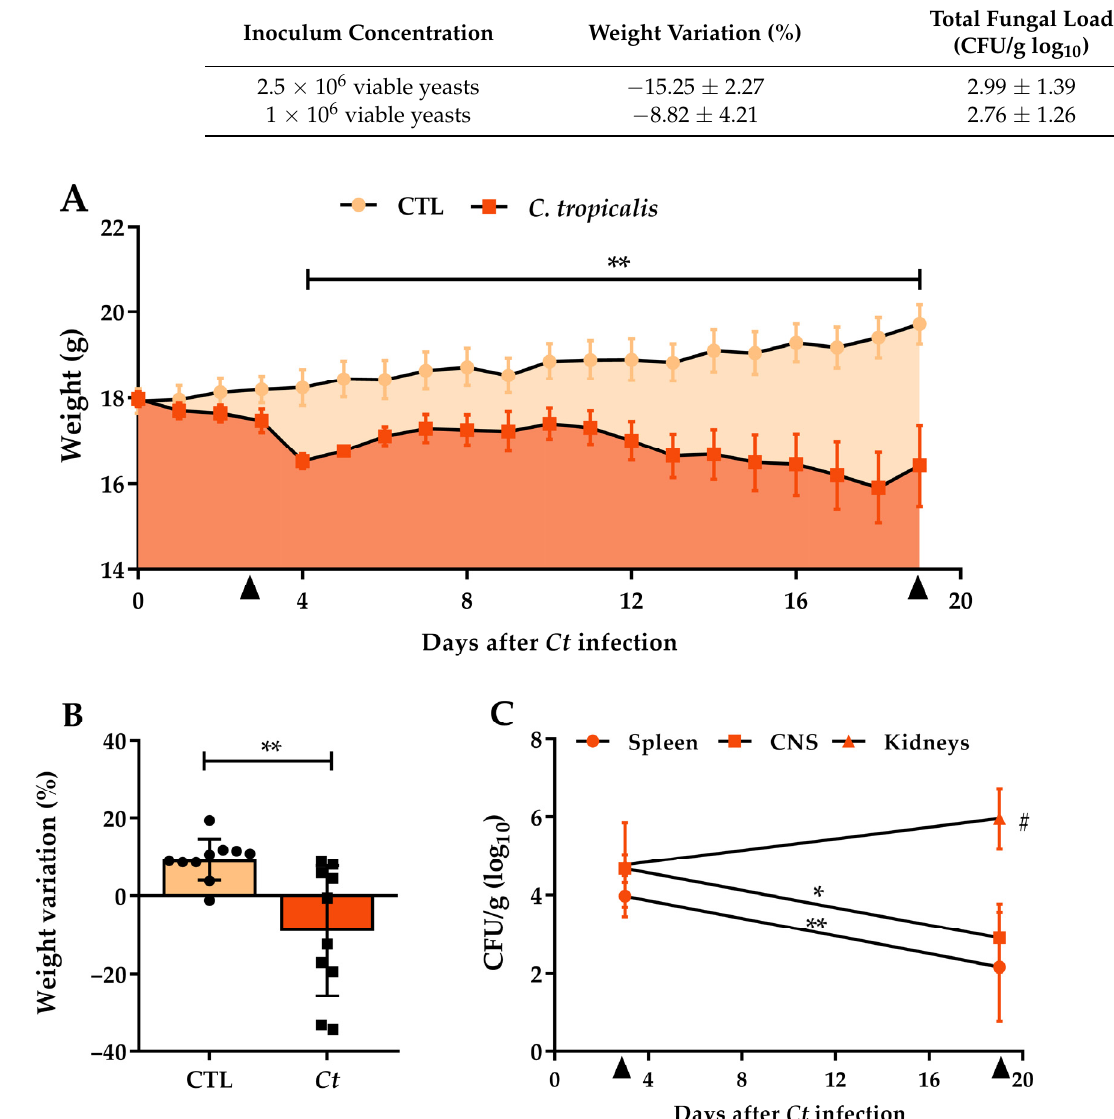
Figure 1. Candida tropicalis systemic infection in C57BL/6 mice. Female C57BL/6 mice were infected with 1 × 10 6 viable C. tropicalis yeasts, and body weight was checked daily ( A ). The percentage of weight loss ( B ) was calculated considering the body weight variation between the initial and the final day of the experiment. The animals were evaluated on the 3rd and 19th days for the number of colony forming units per gram of tissue (CFU/g) in the CNS (brain and spinal cord), spleen and kidneys ( C ). The results are expressed as mean ± SD; n = 6/group (3 days); n = 10/group (19 days); two independent experiments; * p < 0.05 and ** p < 0.01. # Represent significant difference in CFU between kidneys and CNS/spleen samples at 19th day after